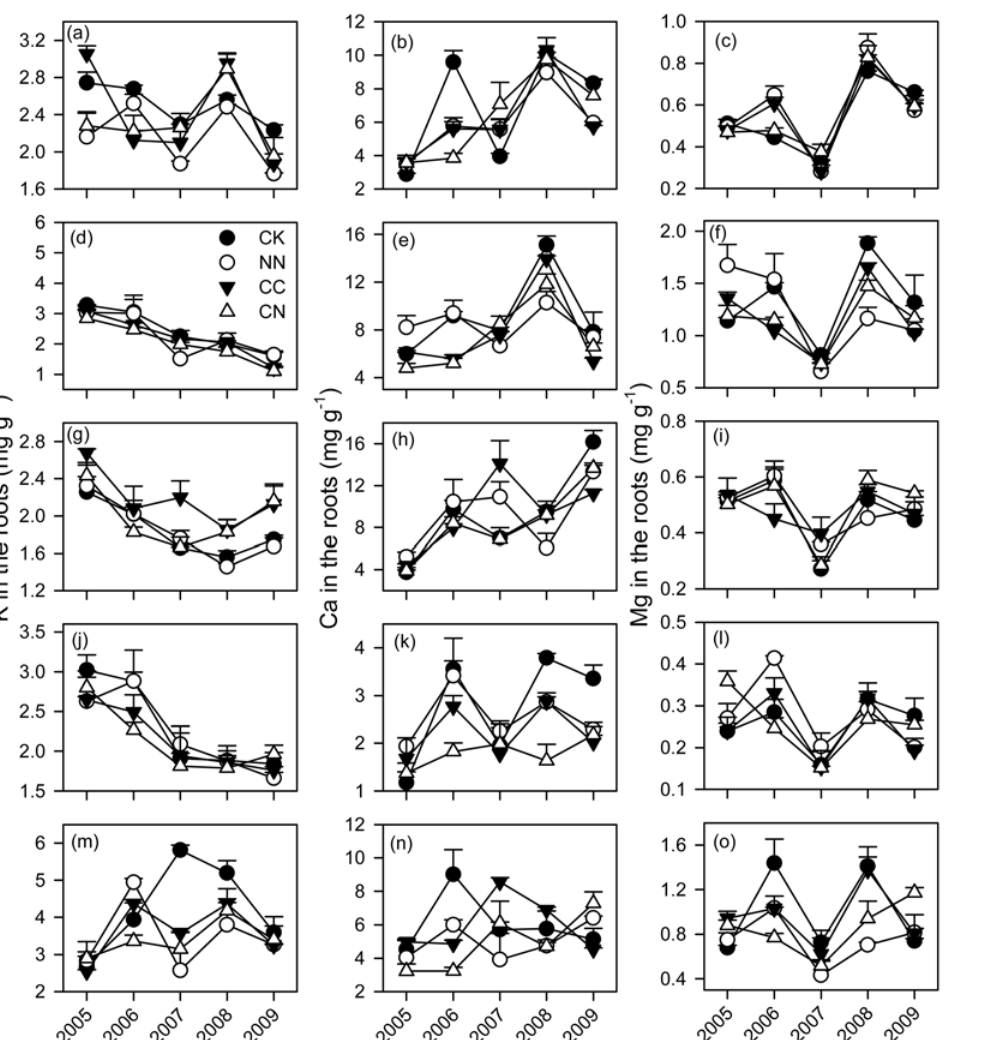
Fig 2. Concentrations of metal cations in the roots of five subtropical tree species exposed to different CO 2 and N treatments from 2005 to 2009. Each error bar is one standard error. CK, control; NN, ambient CO 2 with N fertilizer; CC, elevated CO 2 without N fertilizer; CN, elevated CO 2 with N fertilizer. (a-c) A . acuminatissima ; (d-f) S . hancei ; (g-i) C . hystrix ; (j-l) O . pinnata ; (m-o) S . superba